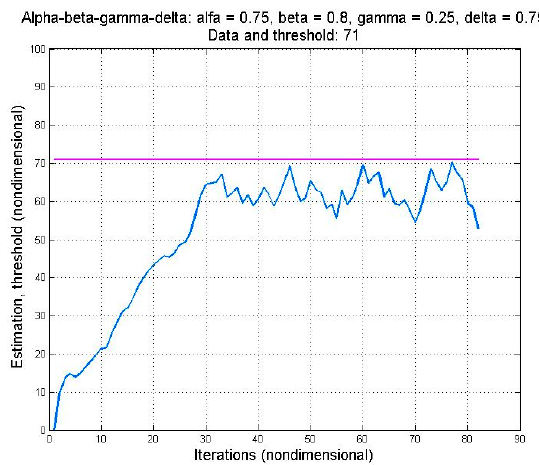
Figure 17. The α – β – γ – δ filter is no longer able to provide an estimate that exceeds the threshold of 71.